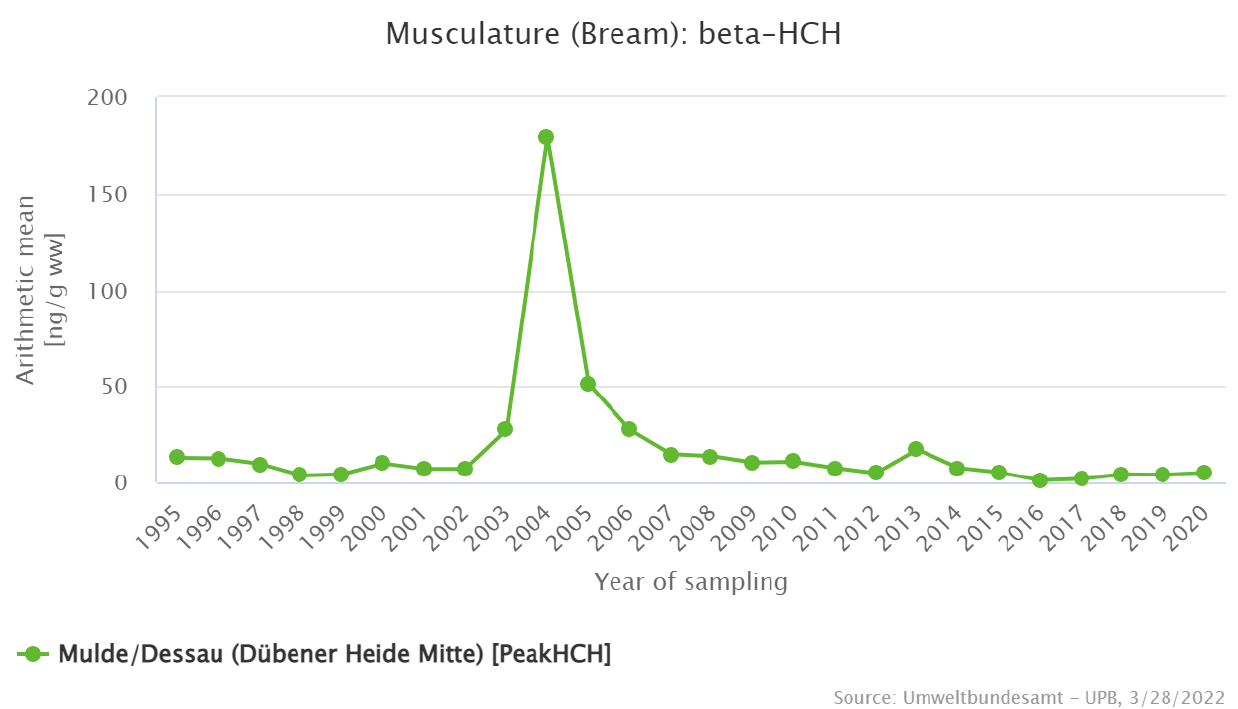
Figure 4. Concentrations of beta-hexachlorocyclohexane in muscles of bream [94]. (Source: Environmental Specimen Bank, Umweltbundesamt